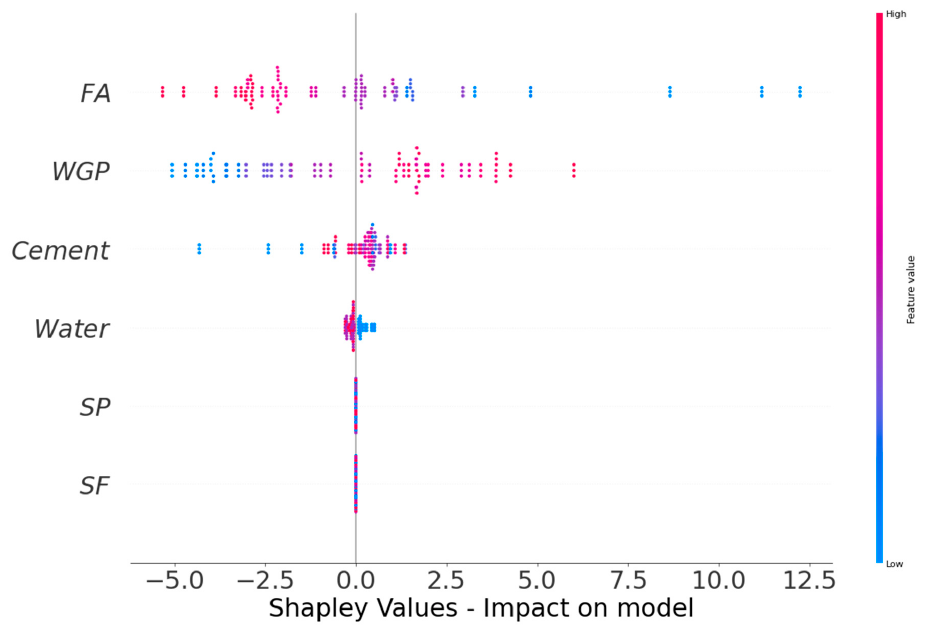
Figure 13. SHAP plot, indicating the impact of raw ingredients on CS and